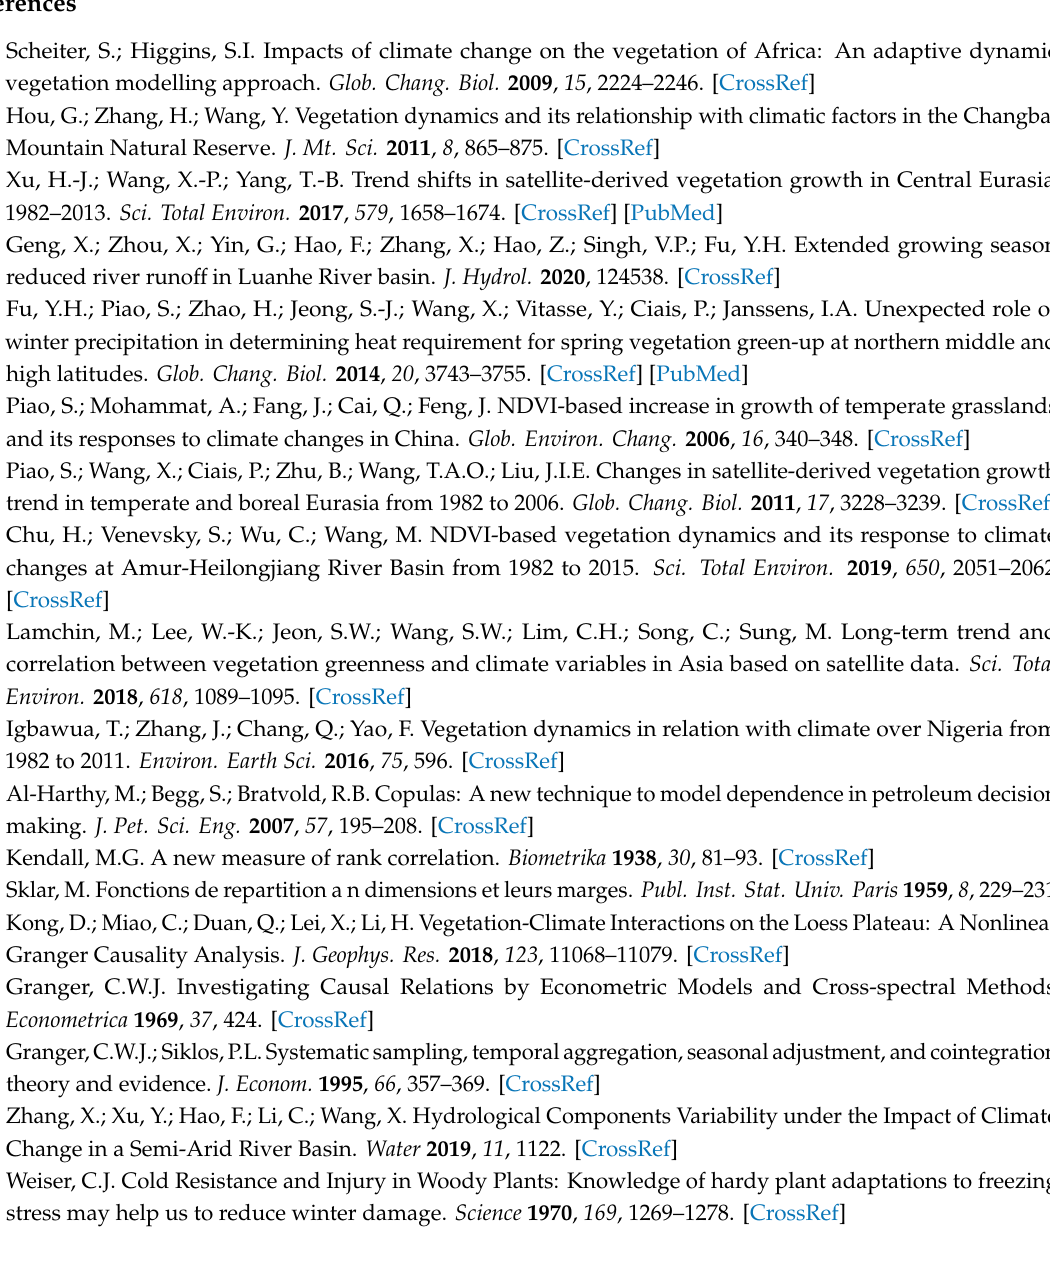
Table S1: Kolmogorov-Smirnov test for marginal distribution, Table S2: The results of Engle–Granger cointegration test in the